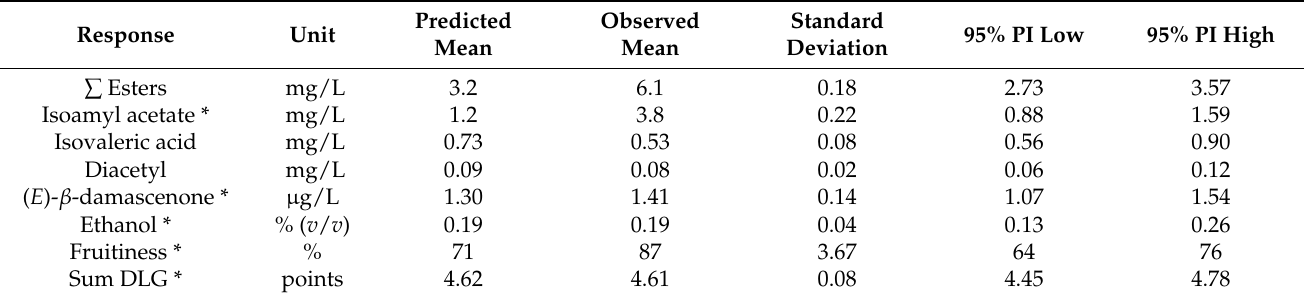
Table 9. Validation of response surface methodology (RSM) model of selected responses with a two-sided predicted interval (PI) of 95%. Values based on